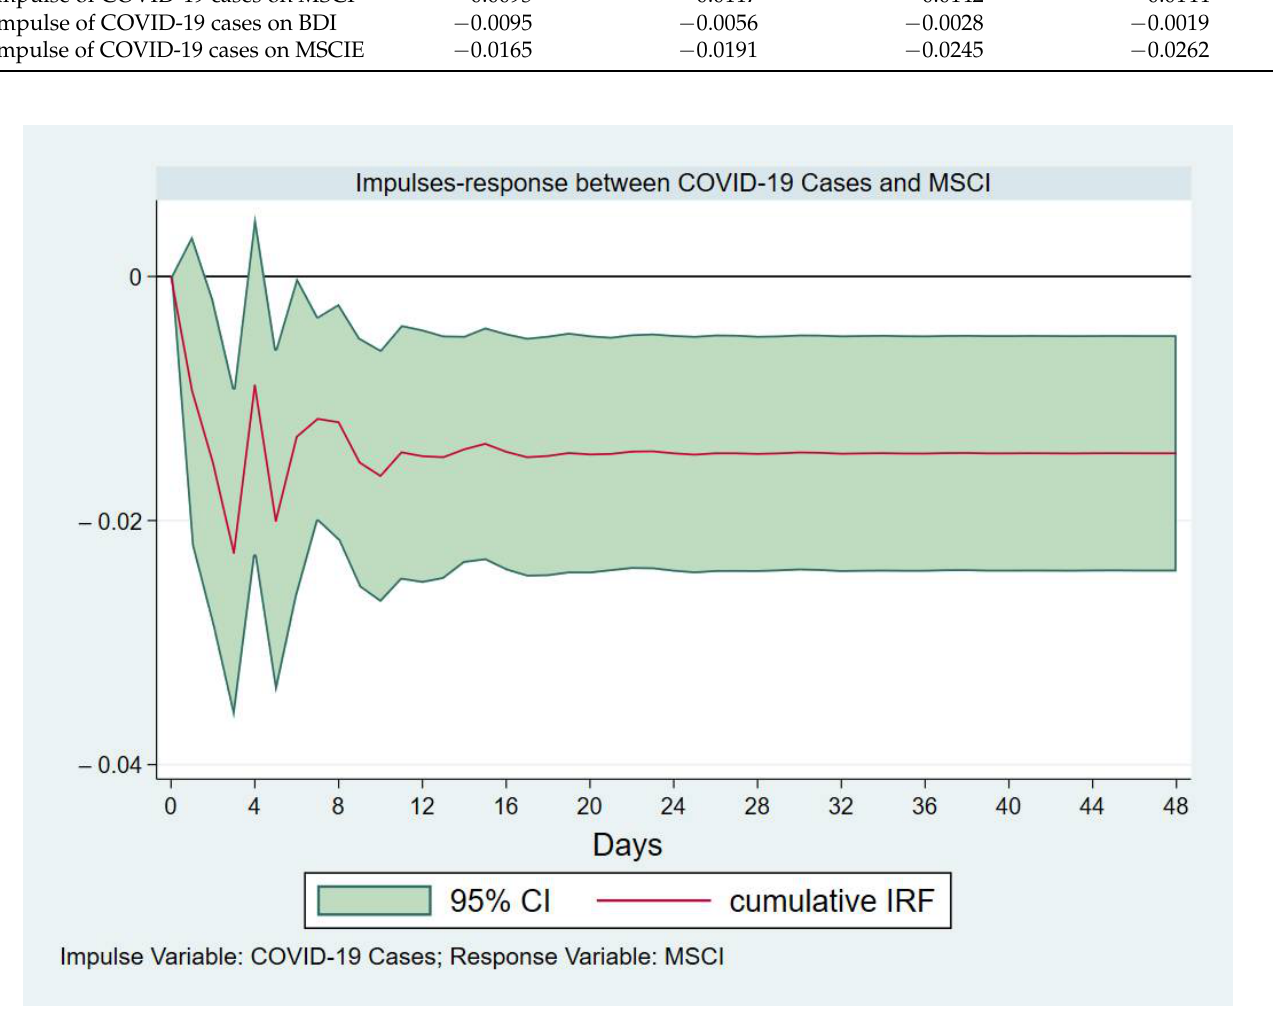
Figure 5. Cumulative impulse response of MSCI to COVID-19 cases. Note: The red line represents the estimates, while the green bands represent lower and upper bounds to the 95% confidence intervals .